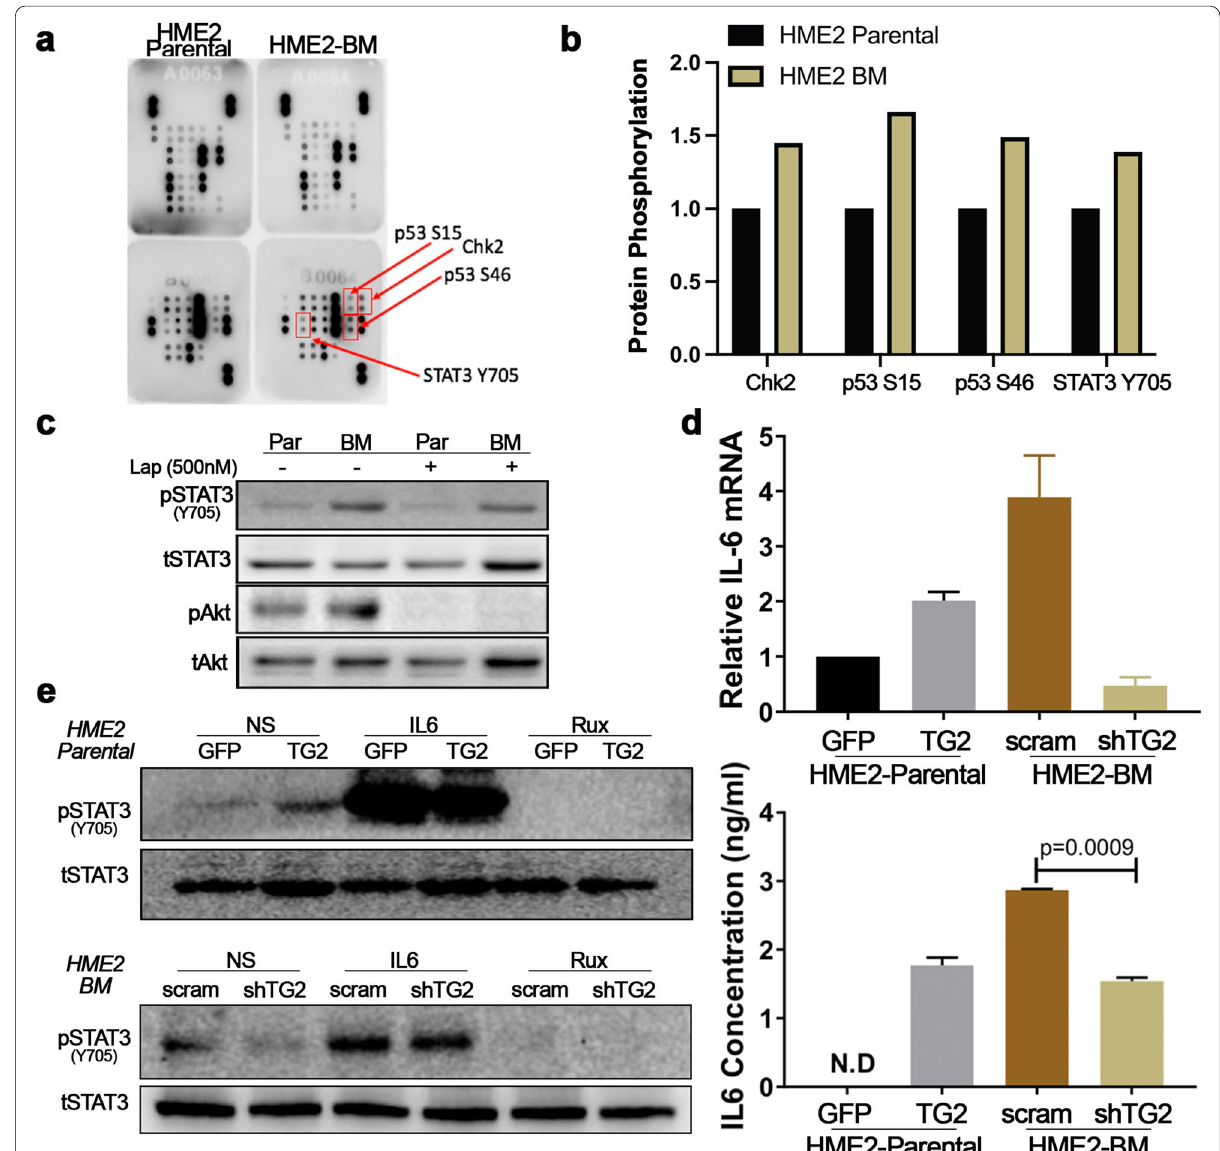
Fig. 3 Transglutaminase 2 causes increased expression of IL-6. a Phosphorylation array comparing lysates derived from HME2-parental and HME2-BM cells. Proteins whose phosphorylation was potentially different between the two cell lines are indicated. b Spot intensity for the indicated sites of phosphorylation. Intensity values were normalized to the HME2-parental cells. c HME2-parental and HME2-BM cells were treated with Lapatinib (500 nM) for 2 h and analyzed for phosphorylation of STAT3 and AKT. Analysis of total levels of STAT3 and AKT served as loading controls. Immunoblots are representative of at least three independent experiments. d Transcript (upper graph) and protein (lower graph) levels for IL-6 in HME-parental and HME2-BM manipulated for TG2 expression were quantified using qRT-PCR and AlphaLISA. Transcript levels are expressed relative to GFP expressing HME2-parental cells. All data are the mean SE of three independent experiments resulting in the indicated p -values. e ± HME2-parental and HME2-BM cells manipulated for TG2 expression were stimulated with IL-6 (20 ng/ml) for 30 min or treated with ruxolitinib (1 µM) for 6 h and analyzed for phosphorylation of STAT3. Analysis of total levels of STAT3 served as loading controls. Immunoblots are representative of at least three independent